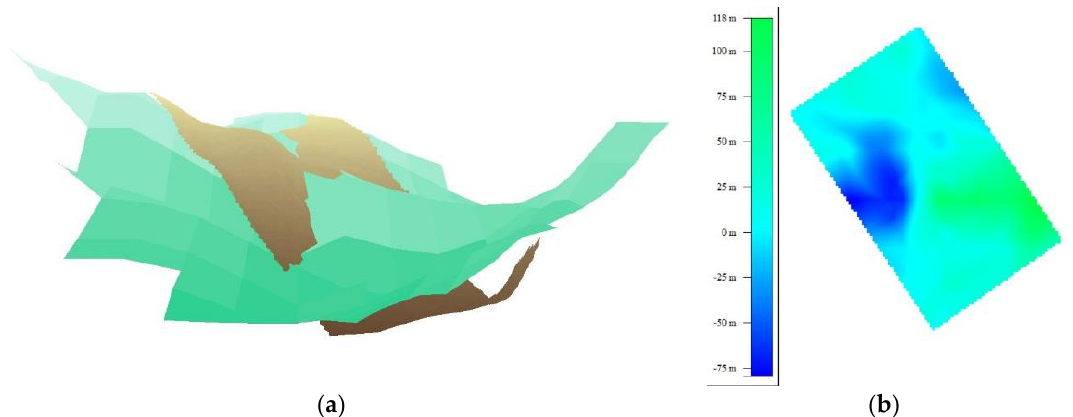
Figure 16 . Comparison of SRTM DEM and NDTM: ( a ) Spatial comparison of SRTM DEM in green tones and NDTM in brown tones and ( b ) hypsometric display of height differences, which range from - 75 to 100 meters.